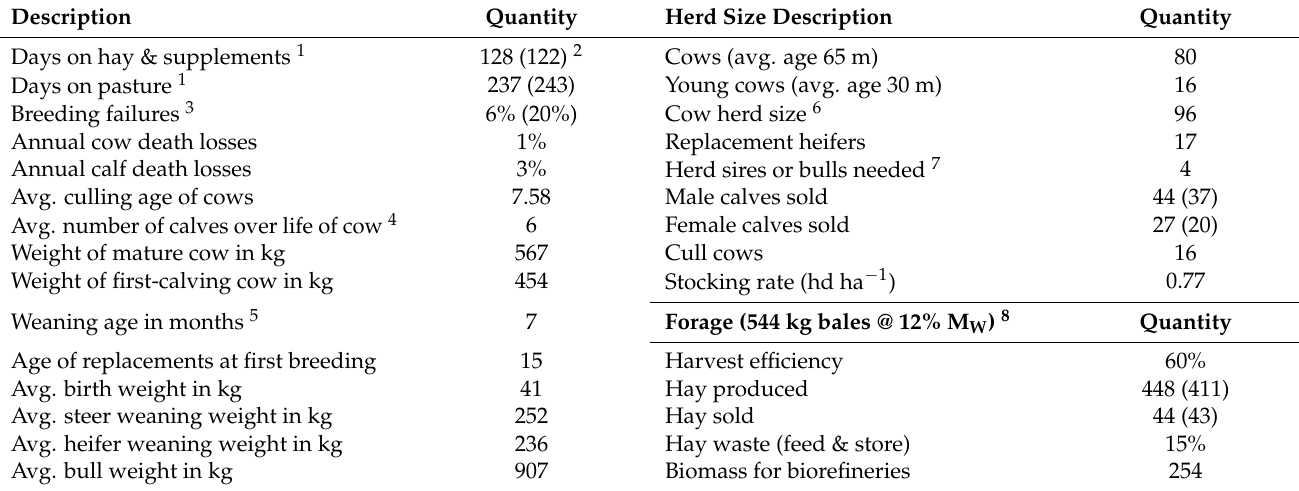
Table 2. Select herd and hay management characteristics for a beef cow-calf operation with 96 cows calving in autumn and